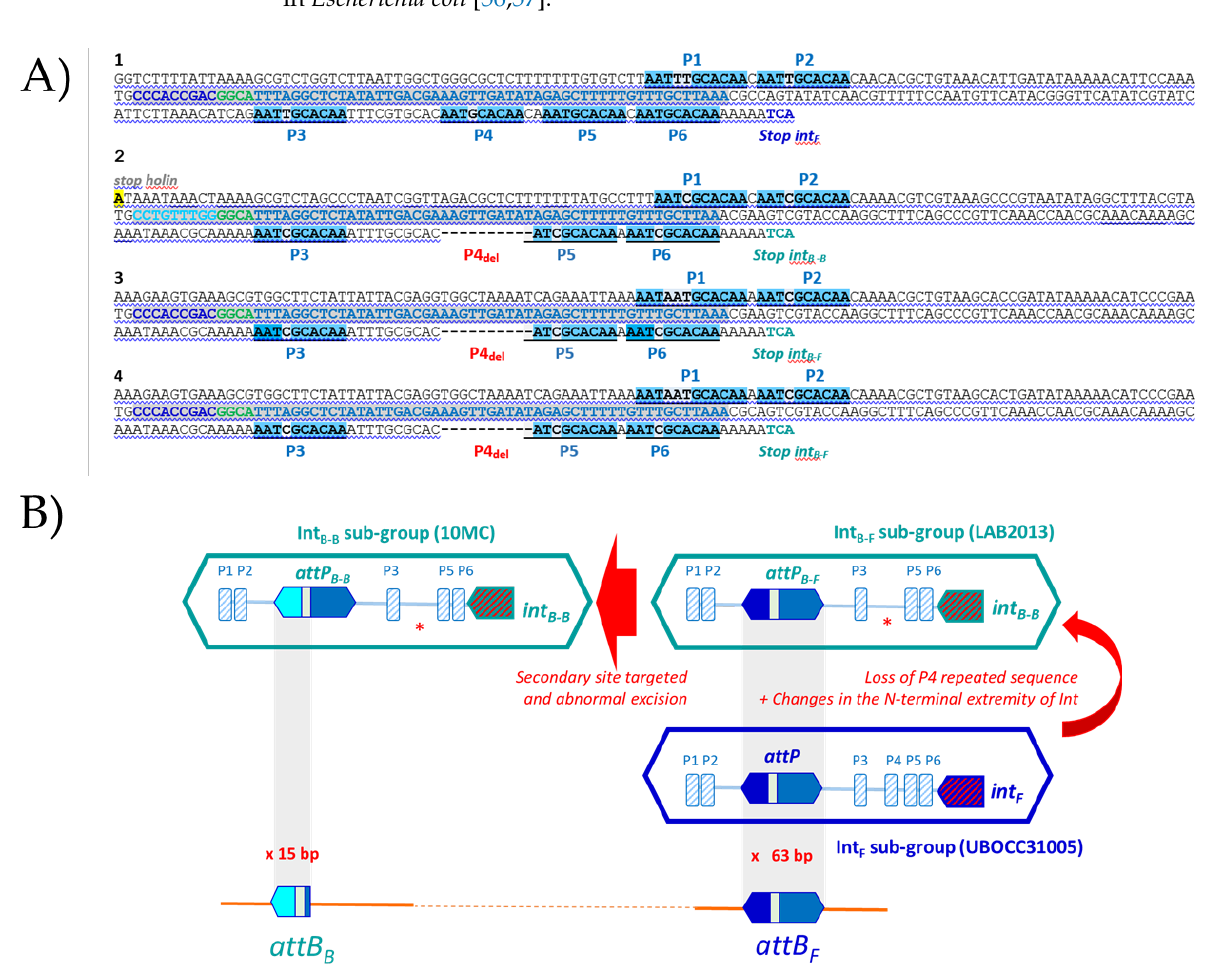
Figure 4. Interrogation of oenococcal genomes for the SSR units of Int B-B , Int B-F and Int F prophages. ( A ) Alignments of the attP regions involved in SSR for Int F phages (1 in blue), the proposed sub-types Int B-B and Int B-F phages (3 and 4 in green). 1, Int F prophage from strain UBOCC315005; 2, Int B-B prophage from strain IOEBB10; 3, Int B-F prophage from strain LAB2013; 4, Int B-F phage OE33PA. P1 to P6, Direct repeats. The 63 bp block identity is in gray. ( B ) Boxed sequences represent the attP sequences of Int B and Int F phages. Arrows indicate the possible complex mechanisms of evolution of SSR units during niche adaptation.